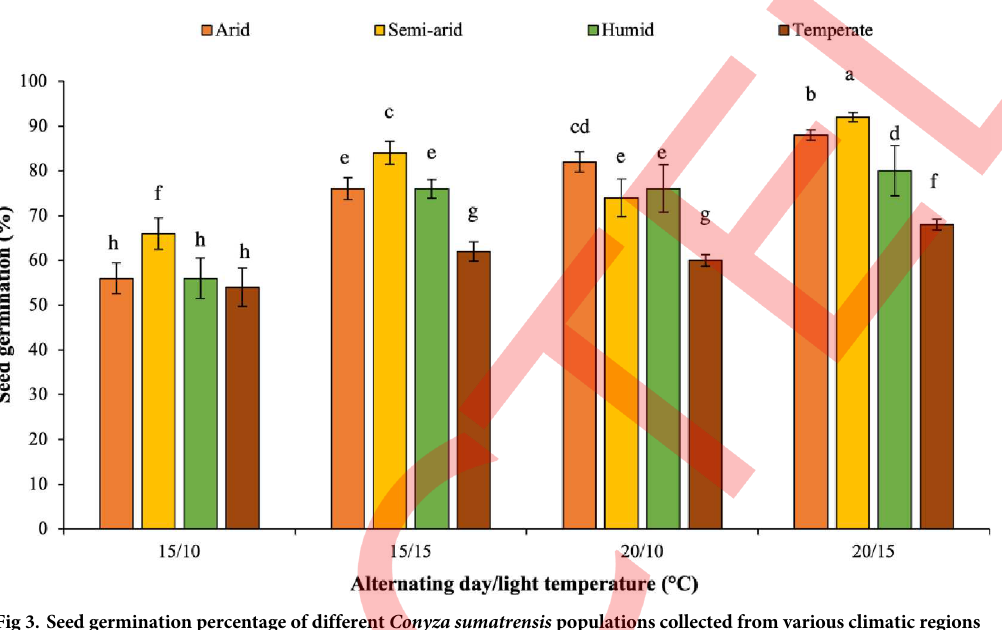
Fig 3. Seed germination percentage of different Conyza sumatrensis populations collected from various climatic regions under different fluctuating day/night temperatures.